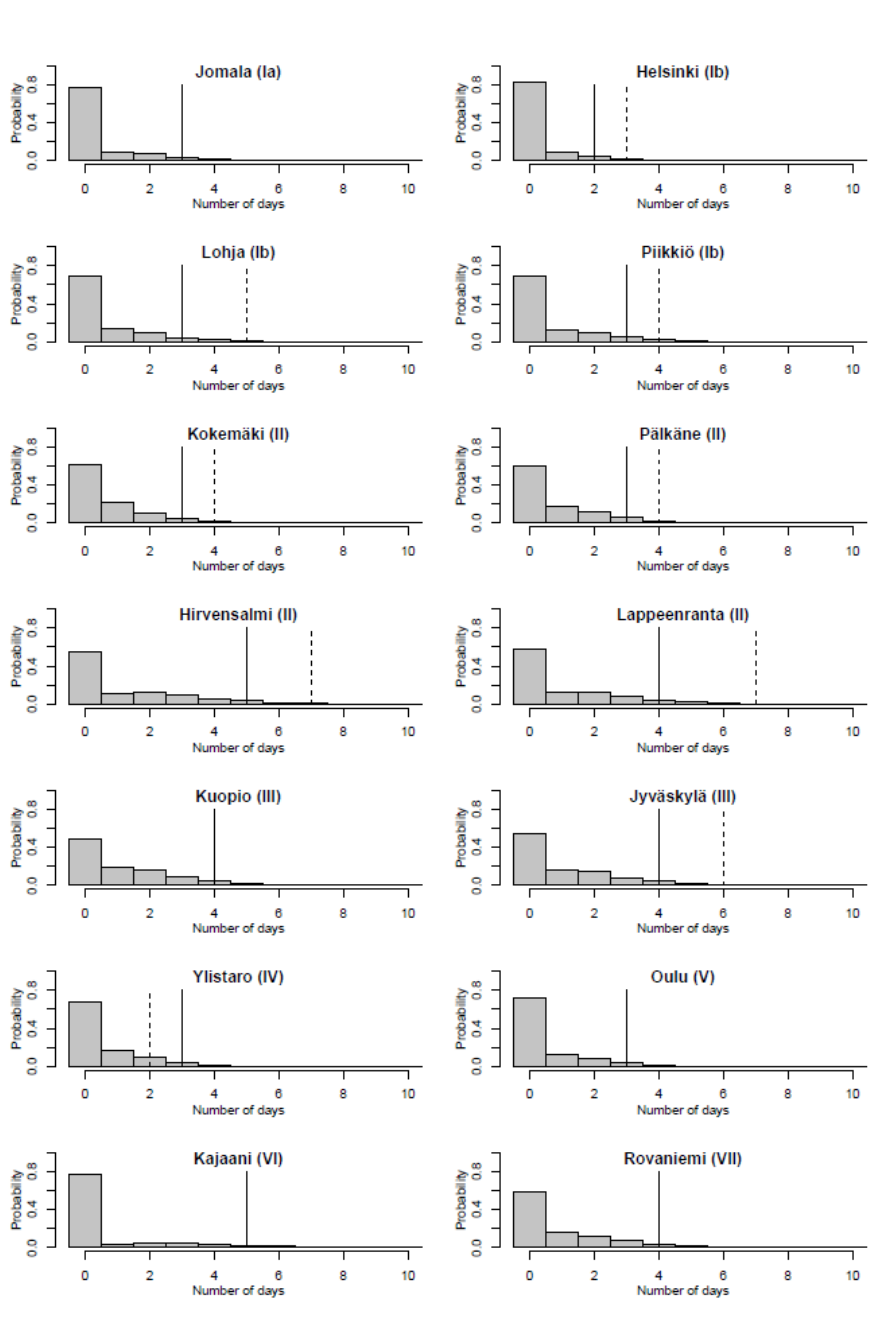
Fig. 3. The distribution of the number of “infection days” per year for the studied geographical locations for the cultivar Lobo. The bars show the predictive probability distributions of “infection days” obtained with Bayesian analysis, and the solid lines indicate the respective upper bound of 95% HPD-interval (i.e. highest posterior density interval). The broken lines indicate the highest number of “infection days” predicted for the years 1993 − 2012 by the Maryblyt analysis. (When the lines overlap, only the solid line is visible.) The plant growth zones of the locations are shown in